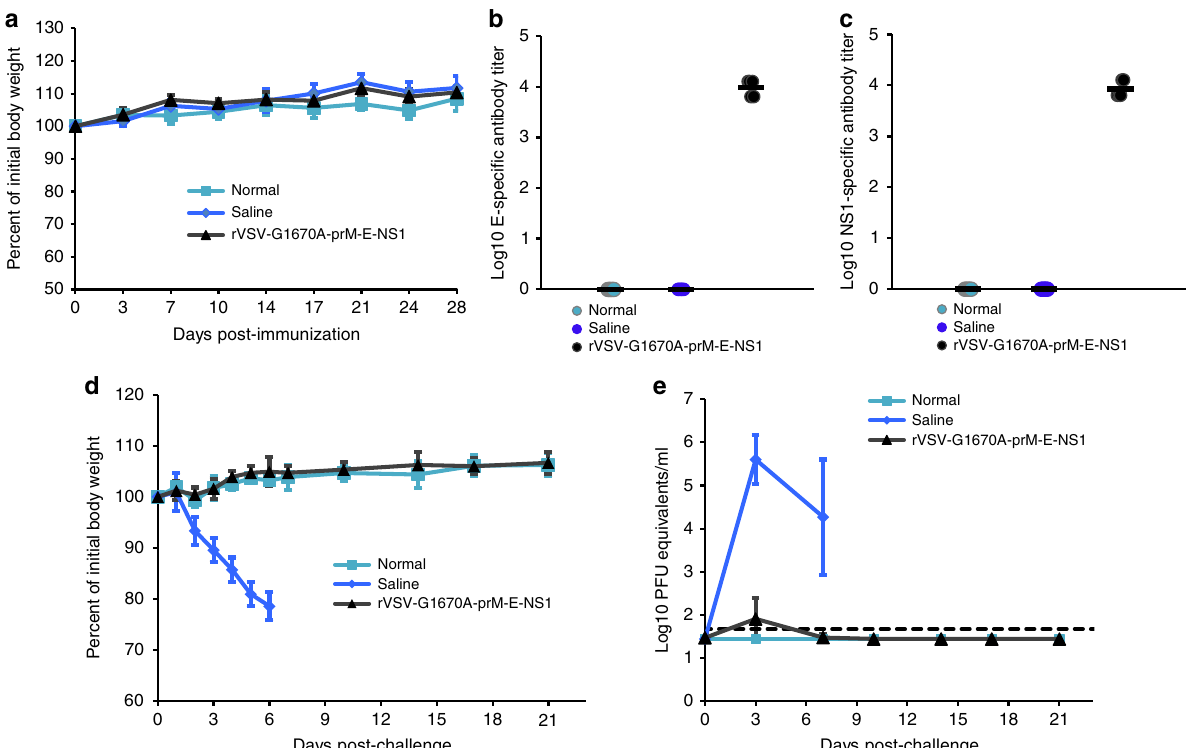
Fig. 8 Validation the safety and immunogenicity of rVSV-prM-E-NS1 in A129 mice. A129 mice were immunized intramuscularly with 1 × 10 5 PFU of rVSV- prM-E-NS1 or injected with 100 µ l of saline. The body weight for each mouse was evaluated at the indicated time points ( a ). Data shown are mean of 5 mice ± standard deviation. After immunization, blood samples were collected at week 4. ZIKV E-speci fi c antibody ( b ) and NS1-speci fi c antibody ( c ) was measured by ELISA. ELISA titers are shown as GMT of 5 mice (black bars). At week 4 post-immunization, mice were challenged with ZIKV, and their body weight ( d ) and viremia ( e ) were monitored every 1 or 3 days until day 21. Data shown are mean ( d ) or GMT ( e ) of 5 mice ± standard